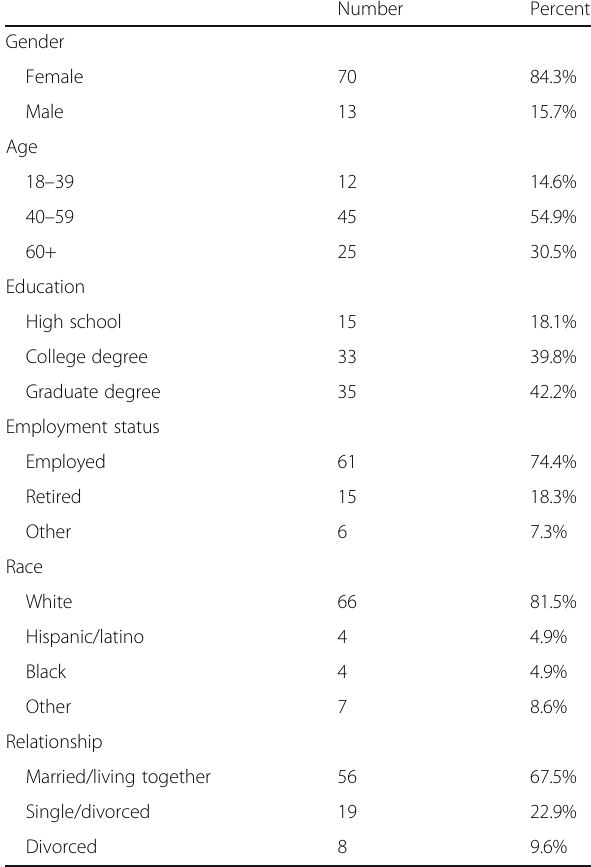
Table 2 Demographic information